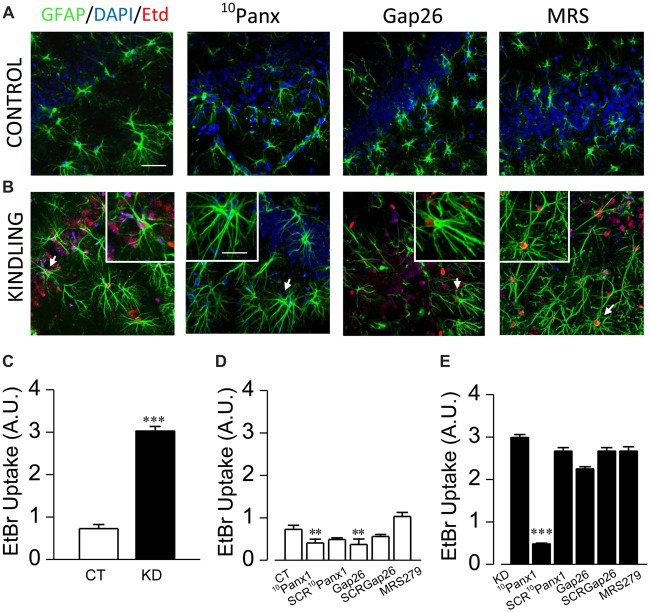
Panx1 HCs activity is enhanced in astrocytes from kindled hippocampi. Representative EtBr uptake (red) in stratum radiatum and nuclear layer (blue, DAPI) astrocytes labeled with GFAP (green) from control (A) and kindled (B) hippocampal slices taken in basal conditions (left end) and in the presence of 10Panx1 (200 μM), Gap26 (200 μM) and MRS2179 (MRS, 10 μM), applied 30 min prior EtBr uptake assays (scale bar, 25 μm). Astrocytes magnified in each image insert are indicated with white arrows (scale bar, 10 μm). (C) Mean values of EtBr uptake, expressed in arbitrary units, measured from CT and KD slices in basal conditions. Mean astrocytic EtBr uptake in basal conditions and in the presence of 10Panx1 (200 μM), 10Panx1 scrambled (SCR10Panx1 200 μM), Gap26 (200 μM), Gap26 scrambled (SCRGap26, 200 μM) and MRS (10 μM) for CT (D) and (E) KD groups. All averaged data was obtained from n = 100 cells and six slices for each condition; T-test for single comparisons and ANOVA with Bonferroni post hoc analysis for multiple comparisons (*p < 0.05; **p < 0.01; ***p < 0.001).